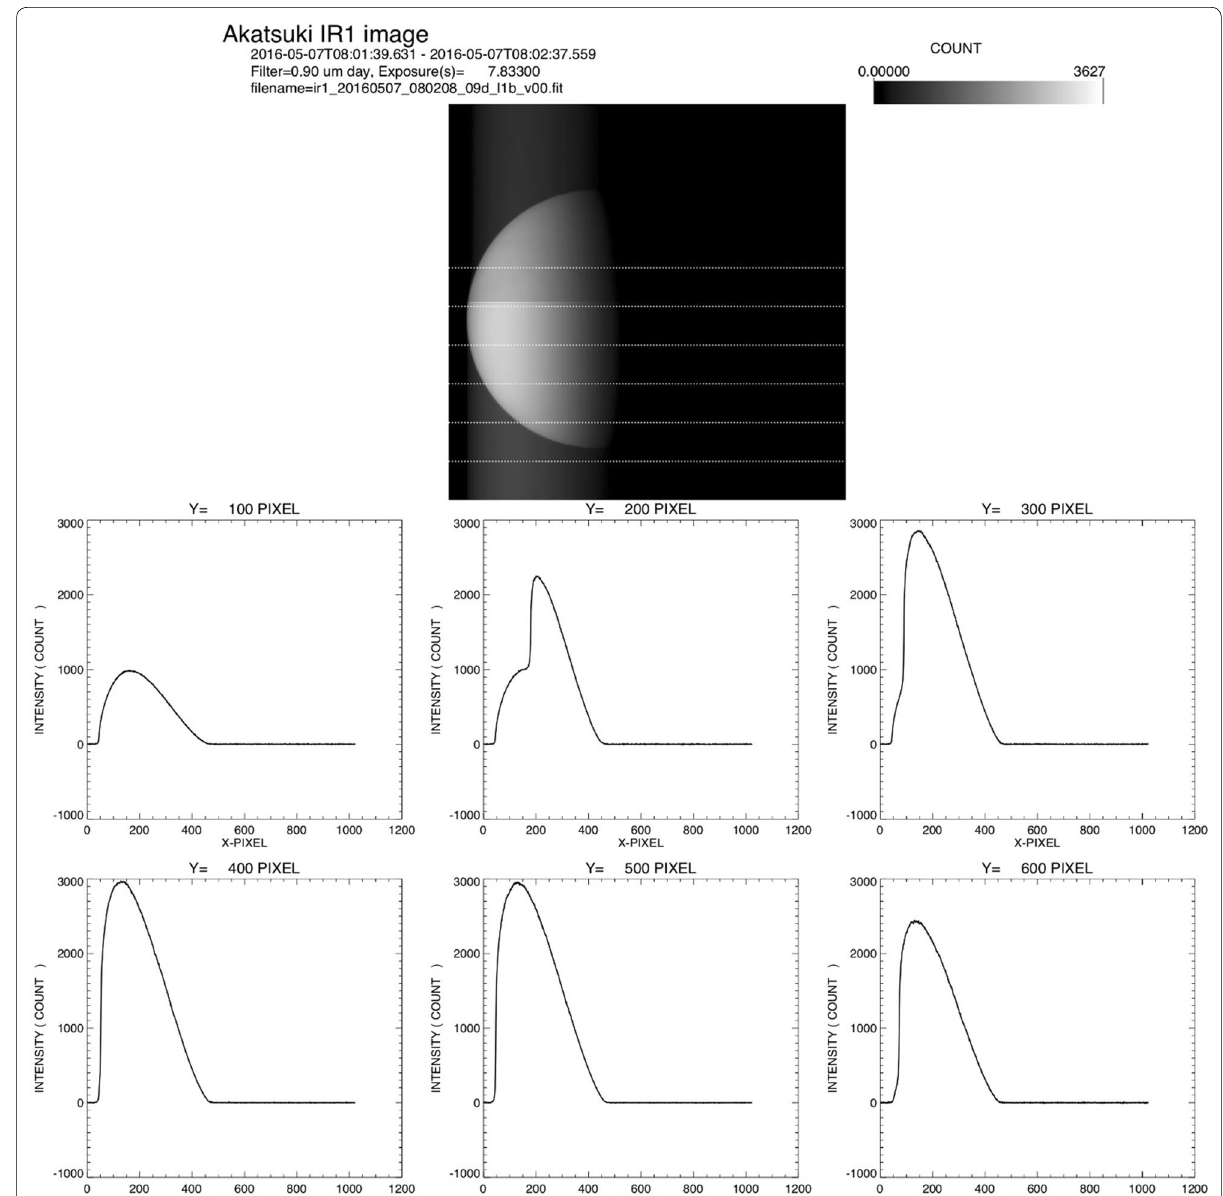
Fig. 7 Horizontal cross section of the Level 1 image before correction shown in Fig. 4a. The six panels on the bottom show intensity along the horizontal dotted line (at y 100–600) in the top image. The date and time are found in the top =